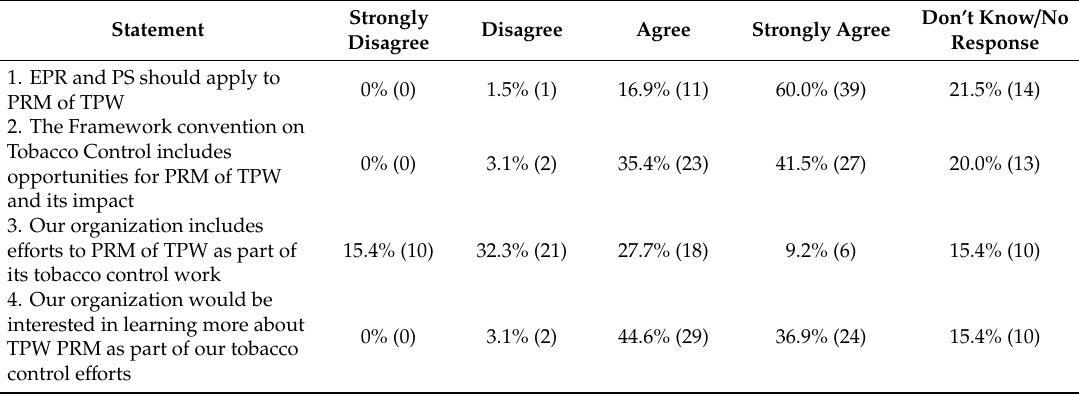
Table 4. TPW stewardship attitudes and practices by members of Framework Convention Alliance, 2019 ( N =